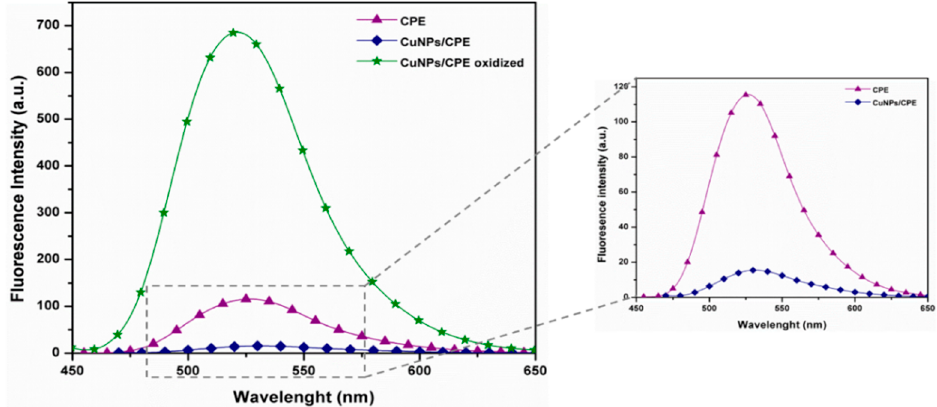
Figure 2. Fluorescence spectra of CPE and CuNP/CPE (stabilized and oxidized) composites in aqueous suspensions (10 − 6 mol·L − 1 ).